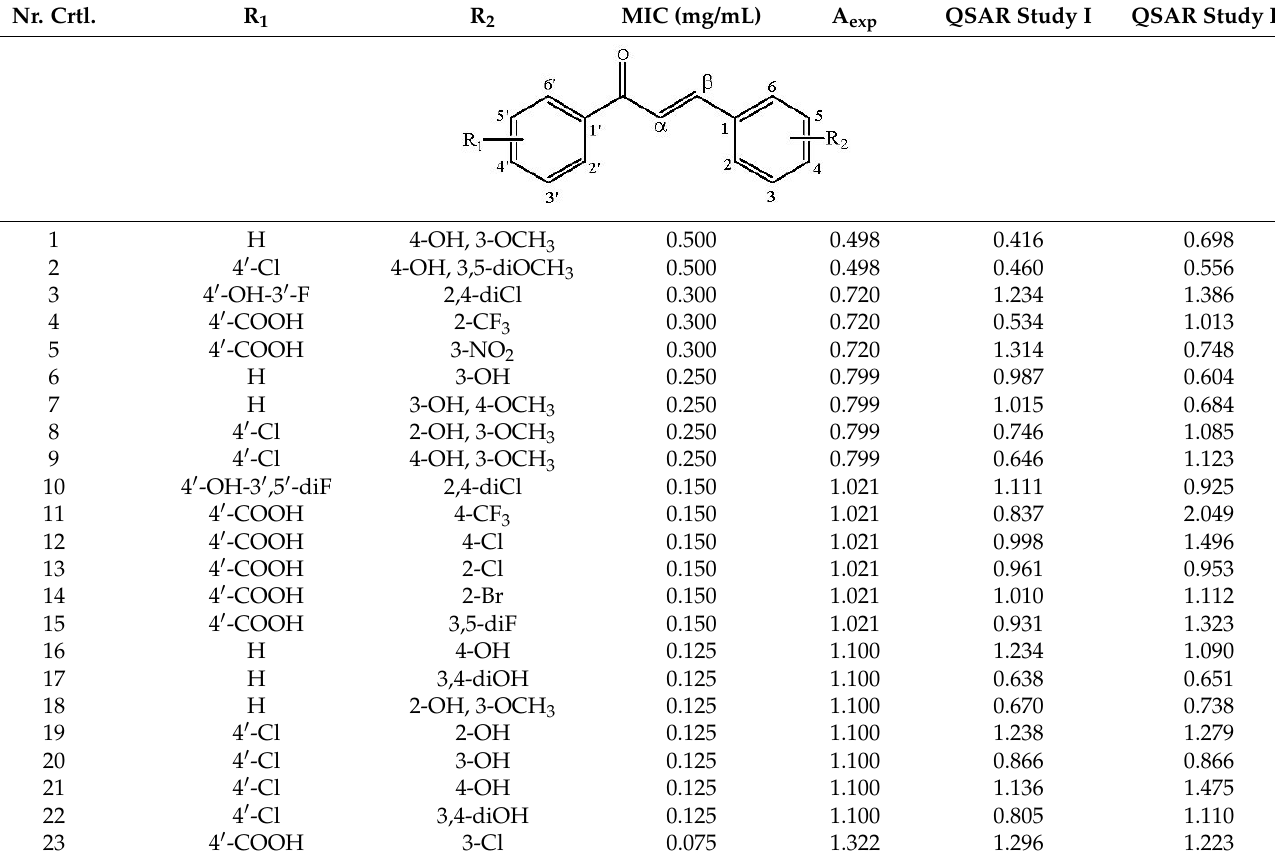
Figure 6. The effects of azulene ‐ containing chalcones on NOS2 and NOX4 expression. Table 7. Antibacterial activity against S. aureus of the chalcones used for QSAR studies. Nr. Crtl.